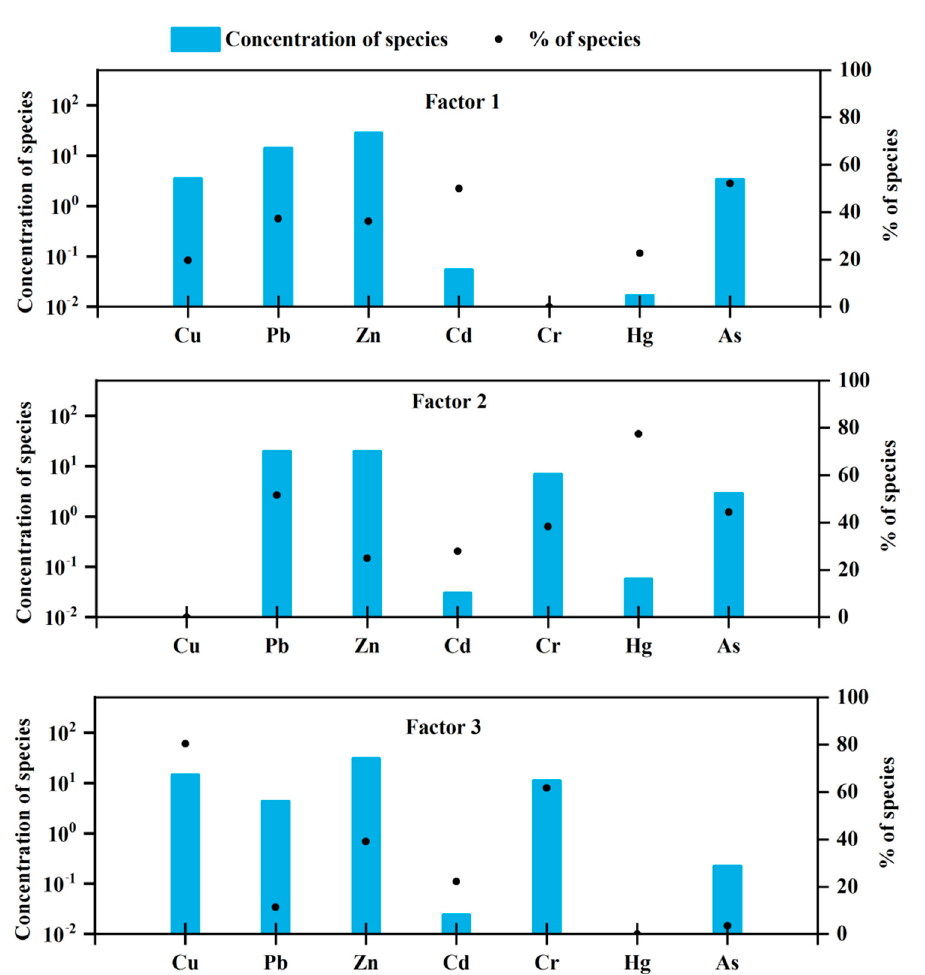
Figure 9. Source profile ratios in the sediments of Xiamen Bay for different PTEs.